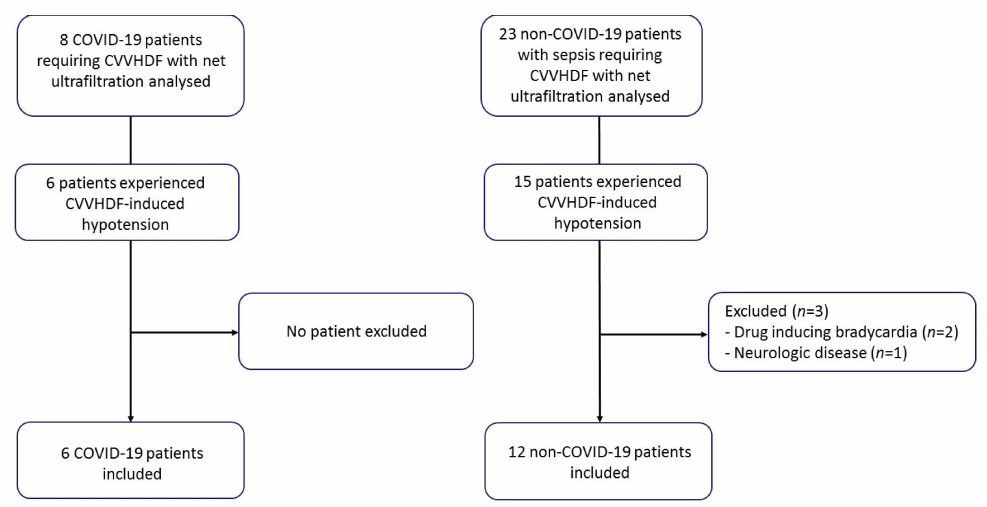
Figure 1. Flowchart of the study. Abbreviations: COVID-19, coronavirus infectious disease 2019; CVVHDF, continuous venovenous hemodiafiltration. Baseline characteristics, clinical and laboratory findings, and hemodynamic param- eters, before CVVHDF-induced hypotension were similar between the two groups. Re- garding the management before CVVHDF-induced hypotension, positive end-expiratory pressure (PEEP) was higher in COVID-19 patients (10.0 (8.0–10.5) cmH 2 0 vs. 6.0 (5.3–6.0) cmH 2 0, p = 0.002), as were propofol and midazolam dosages (200 (200–200) mg/h vs. 160 (75–200) mg/h, p = 0.02 and 4.0 (0.8–5.0) mg/h vs. 0 (0–0) mg/h, p = 0.02, respectively) (Table 1). Table 1. Patients’ baseline characteristics, clinical and laboratory findings, management before CVVHDF-induced hypoten- sion, and description of CVVHDF-induced hypotension between COVID-19 patients and non-COVID-19 patients. All Patients Variables ( n =